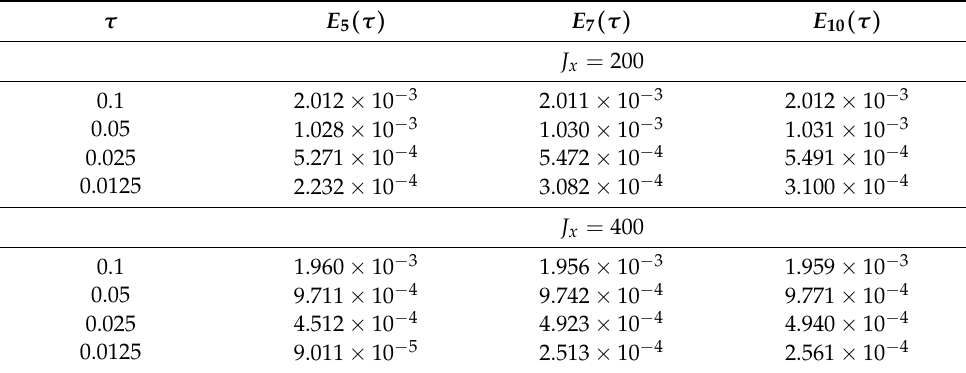
Table 5. Errors E m ( τ ) for the discrete solution of the BURA-BRASIL scheme (16) for a sequence of time steps τ and J x =